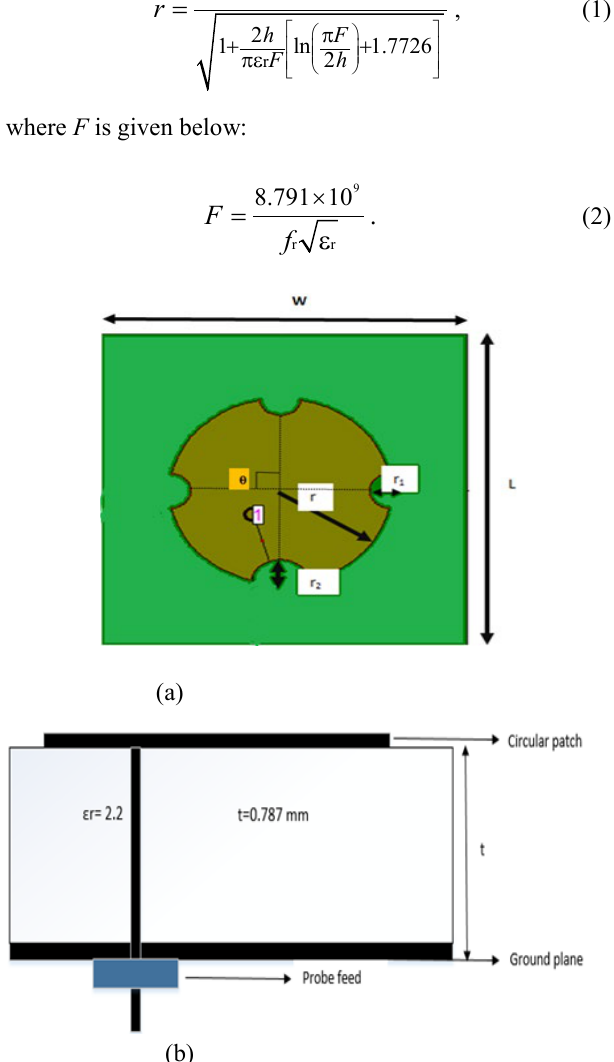
Fig. 1. The layout of the proposed antenna: (a) top view; (b) cross-sectional view.